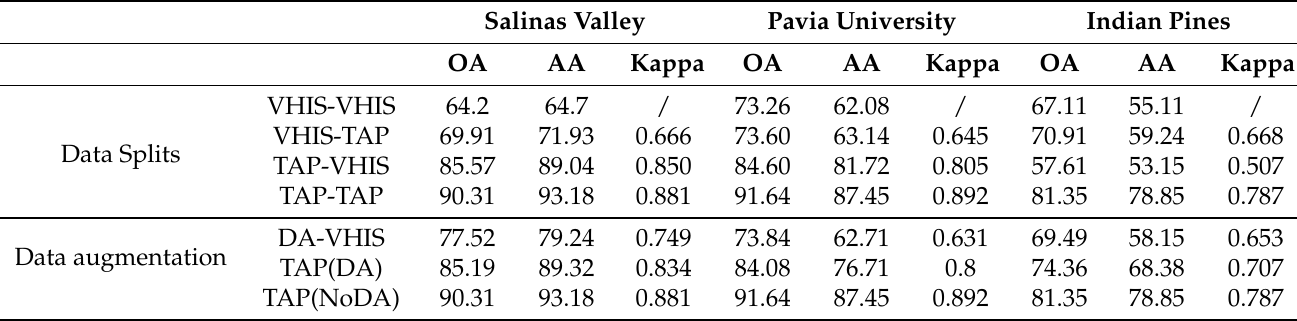
Table 11. Physicochemical characteristics of some grains of sorghum sampled in the main markets of Maroua town and used for the production of the indigenous